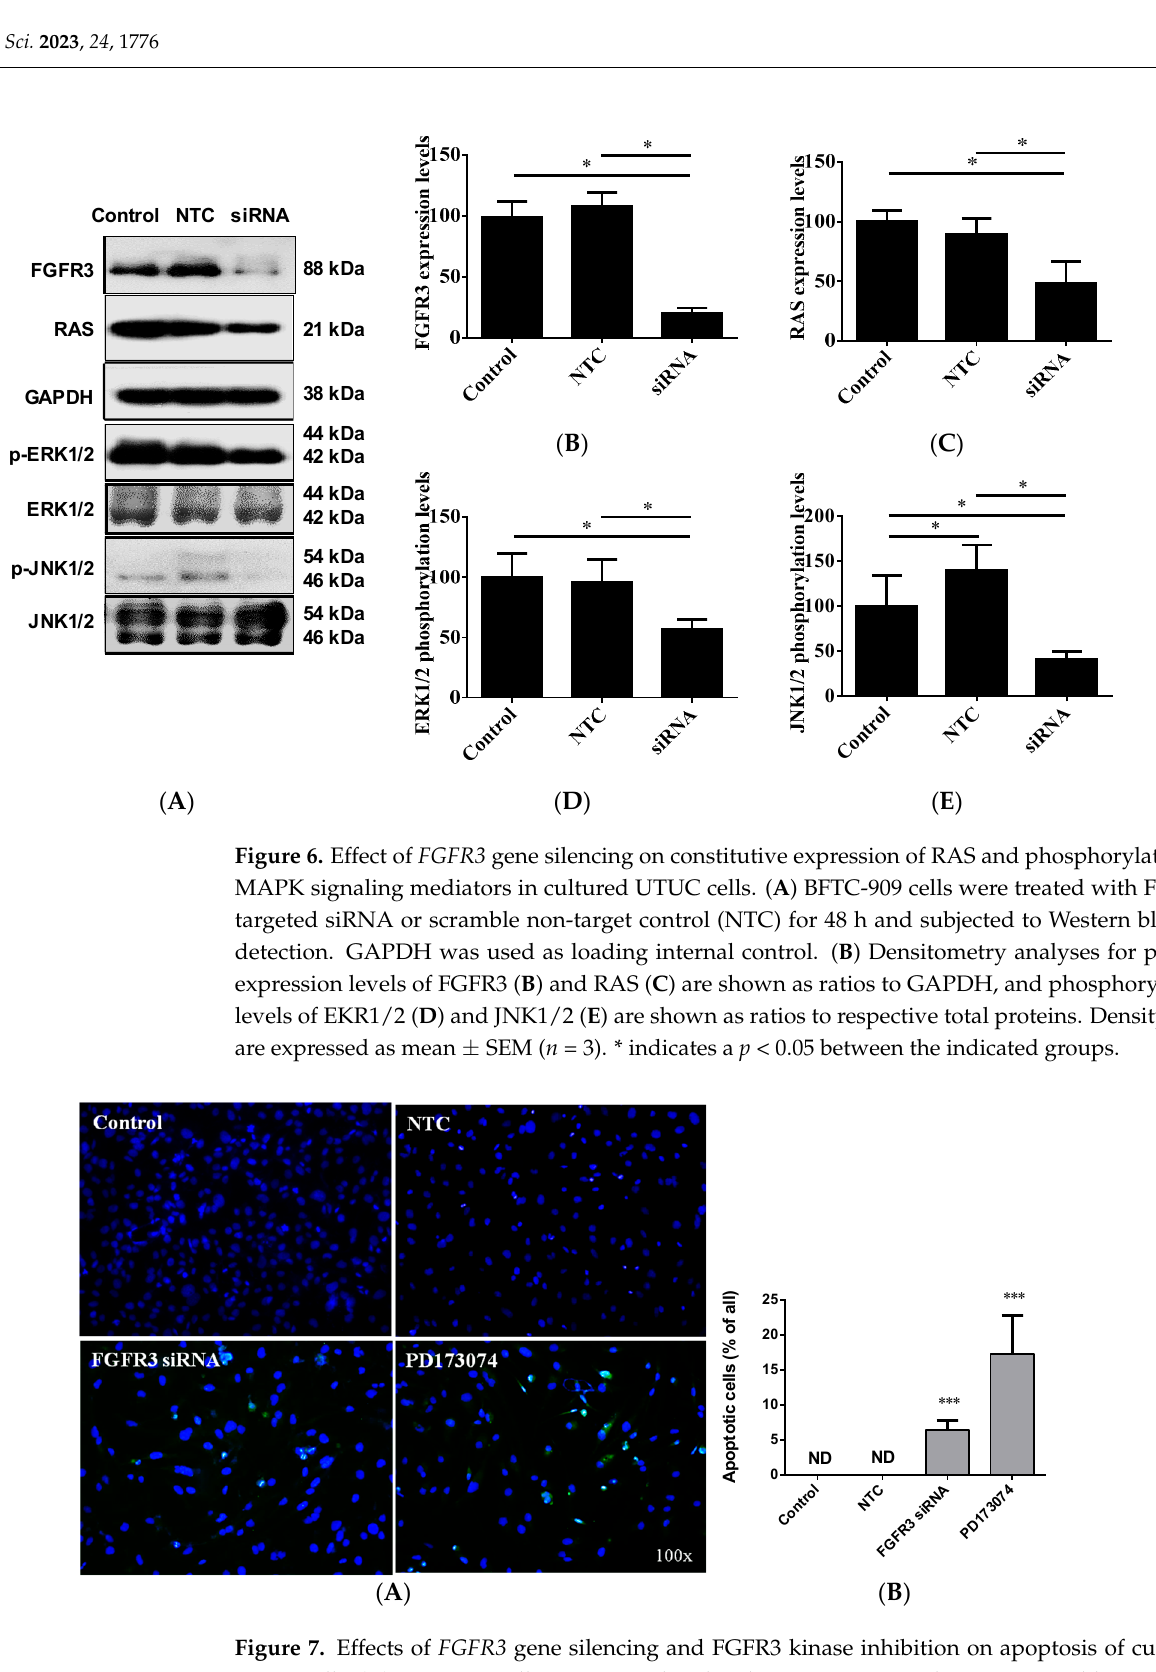
Figure 8. A mechanistic scheme depicting the effects of FGFR3 gene silencing on RAS/mitogen-activated protein kinase (MAPK) signaling and renal pelvis tumorigenesis. Upon stimulation by fibroblast growth factor (FGF), the intracellular tyrosine kinase domain of FGF re- ceptor 3 (FGFR3) may deliver the mitogenic signal through RAS/MAPK cascade and downstream mediator activation, including extracellular signal-regulated kinase (ERK) and c-Jun N-terminal kinase (JNK). Hence, FGFR3 overexpression and activation may enhance expression of epitheli- al–mesenchymal transition (EMT) transcription factors and mediators, which eventually contribute to tumor progression. Our findings suggest that FGFR3 siRNA delivery is a useful strategy for al-